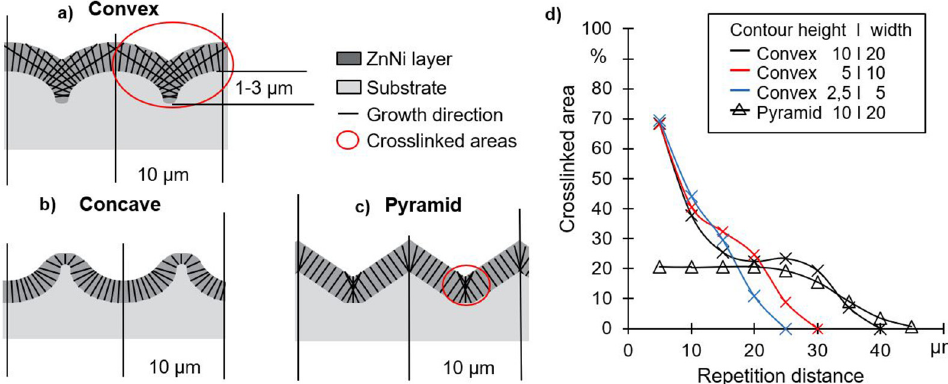
Fig. 1. Different contour shapes for laser structuring and their impact on crystalline growth direction (a-c) and resulting crosslinked area depending on repetition distance (d).